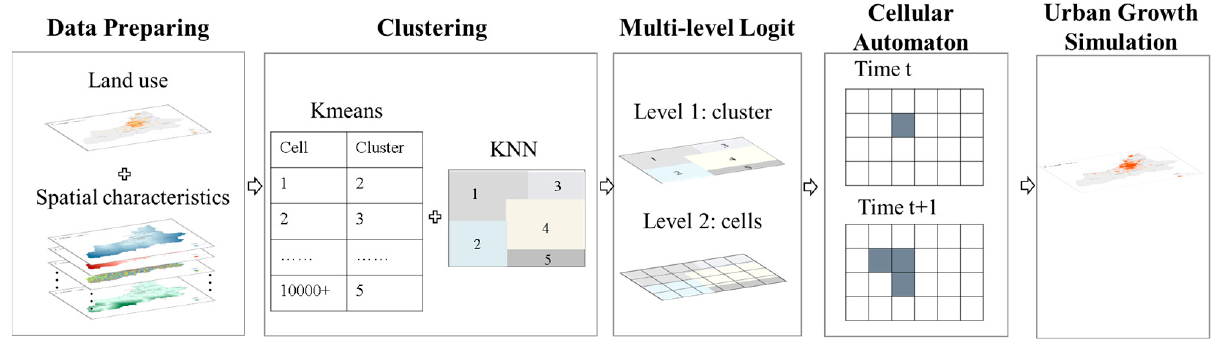
Figure 1. The flowchart of CM-CA model.